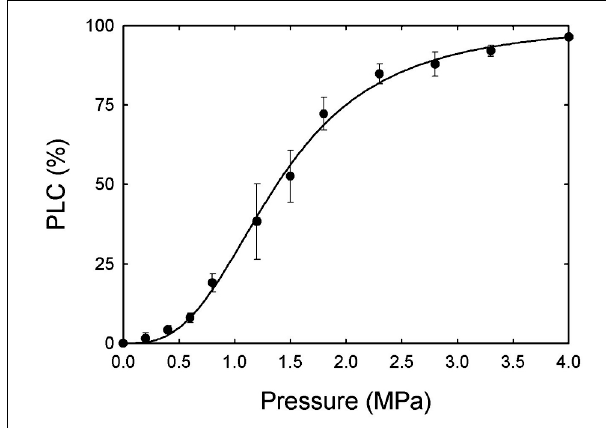
FIGURE 2 |Average percent loss in hydraulic conductance (PLC) was measured on current year stems of A. rubrum after applying pneumatic pressure (PLC 50 = 1.4 MPa) .The minimum pressure required to reduce hydraulic conductivity by 95% was 4.0 MPa ( n = 6).